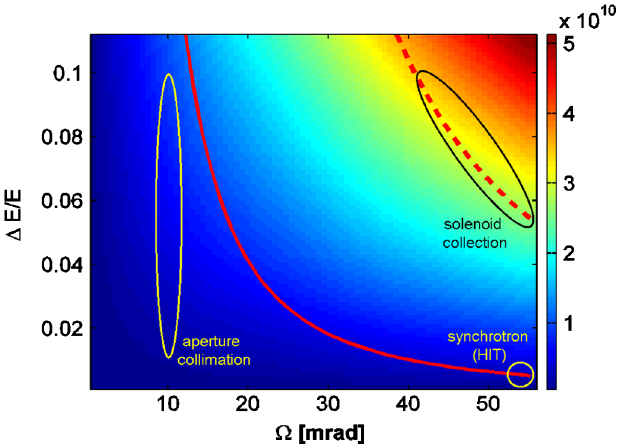
FIG. 11. Contour plots for usable intensities of 200 MeV pro- tons as a function of selected production cone angle and energy window, with curves of two examples for constant chromatic emittance (required emittance) (red solid: (cid:3) ¼ 5 mm mrad ; red dashed: (cid:3) ¼ 50 mm mrad